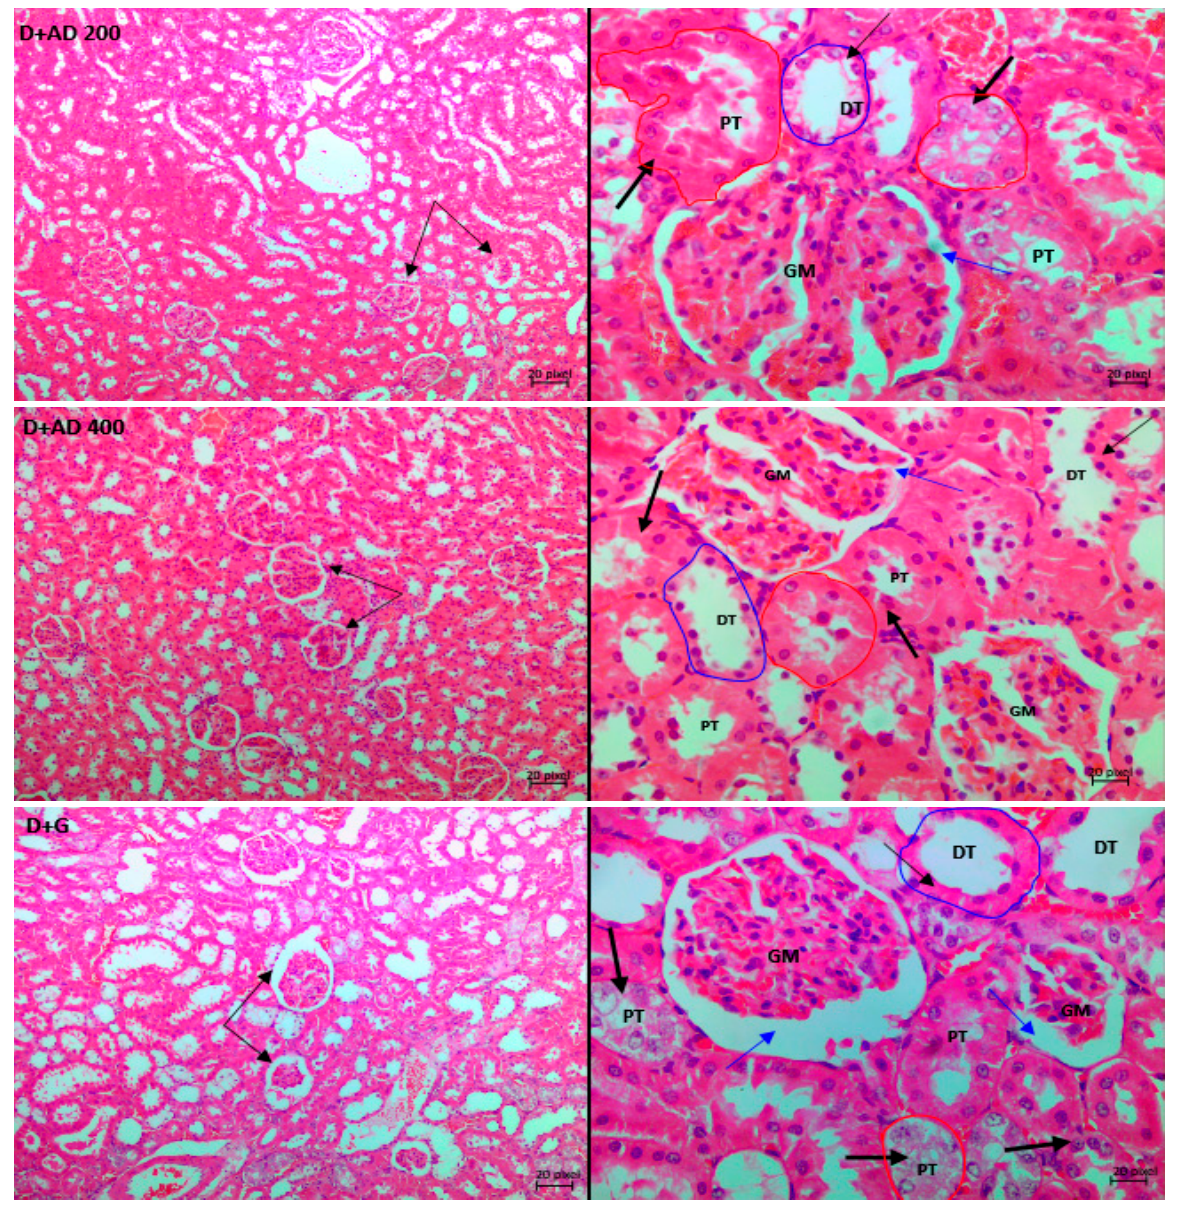
Figure 8. Light photomicrographs of haematoxylin and eosin-stained kidney cortex of normal and diabetic rats. Double arrows are pointing to the bowman’s capsule and glomerulus (GM), while single thin arrows are showing the cells of the distal convoluted tubule (DT). The thick single arrows reveal the cells of the proximal convoluted tubule (PT). The blue arrows points at the bowman’s space. Magnification 10× ( left ) and 40× ( right ).